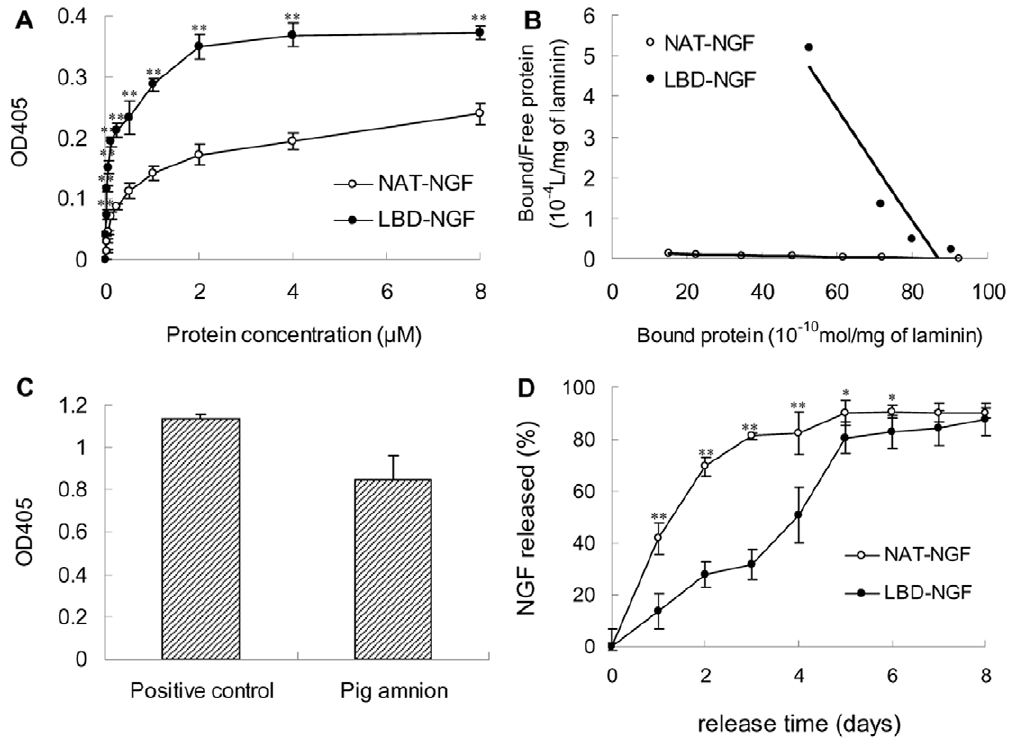
Figure 1. Laminin-binding and sustained release assay of NAT-NGF and LBD-NGF from laminin invitro . (a) Binding curves of NAT-NGF and LBD-NGF to laminin measured by ELISA assay. (b) Kd values for laminin to NAT-NGF and LBD-NGF were calculated using Scatchard analysis. (c) Detection of laminin content in the pig amnion by ELASA assay. (d) Release curves of NAT-NGF and LBD-NGF from laminin in vitro . n=6, *, P , 0.05, **, P , 0.01, determined by two-tailed student’s t